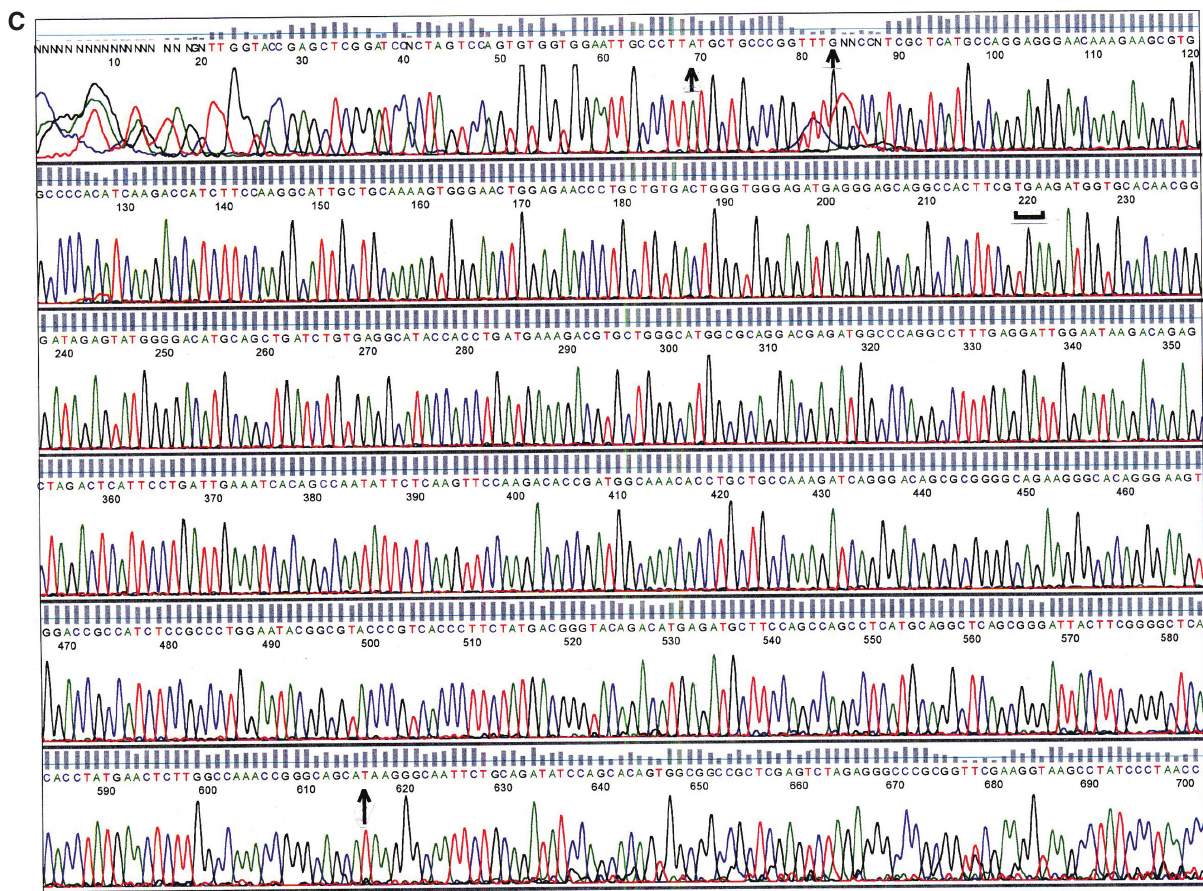
Figure 3: Automated direct APP-cDNA sequence analysis for screening of insert into the pcDNA TM 3.1/V5-His-TOPO ® vector. (A) Sample #7, LNS: Chromatogram of the APP-cDNA sequence read from left to right (5 ′→ 3 ′ ) showed the nucleotide A of the ATG start 148 codon of exon 1 of APP gene ( ↑ ); the beginning of the deletion and substituted by an insertion of 324 bp between exon 1 and exon 18, located after nucleotide A ( ↑ ); the first Opal stop codon TGA, located after nucleotide T (see horizontal bracket mark); the presence of 165 168 nucleotides T (in triplet AGT, see horizontal bar mark) and A (in triplet TAG, see horizontal bar mark); the nucleotide G of the GAG start 351 485 490 codon of exon 18 ( ↑ ); the nucleotide G of the Amber stop codon TAG end codon of exon 18 at the end of APP-cDNA ( ↑ ). (B) Sample #15, 507 LNV: Chromatogram of the APP-cDNA sequence read from left to right (5 ′→ 3 ′ ) showed the nucleotide A of the ATG start codon of exon 1 of 151 APP gene ( ↑ ); the beginning of the deletion and substituted by an insertion of 324 bp between exon 1 and exon 18, located after nucleotide A ( ↑ ); the first Opal stop codon TGA, located after nucleotide T (see horizontal bracket mark); the presence of nucleotides A (in triplet 168 171 354 AGA, see horizontal bar mark) and G (in triplet TGG, see horizontal bar mark); the nucleotide G of the GAG start codon of exon 18 ( ↑ ); 488 493 the nucleotide G of the Amber stop codon TAG end codon of exon 18 at the end of APP-cDNA ( ↑ ). (C) Sample #14, LNV: Chromatogram 510 of the APP-cDNA sequence read from left to right (5 ′→ 3 ′ ) showed the nucleotide A of the ATG start codon of exon 1 of APP gene ( ↑ ); the 69 beginning of the deletion and substituted by an insertion of 533 bp in exon 1, located after nucleotide G ( ↑ ); the first Opal stop codon TGA, 83 located after nucleotide G (see horizontal bracket mark); the nucleotide T at the end of APP-cDNA ( ↑ 218 616